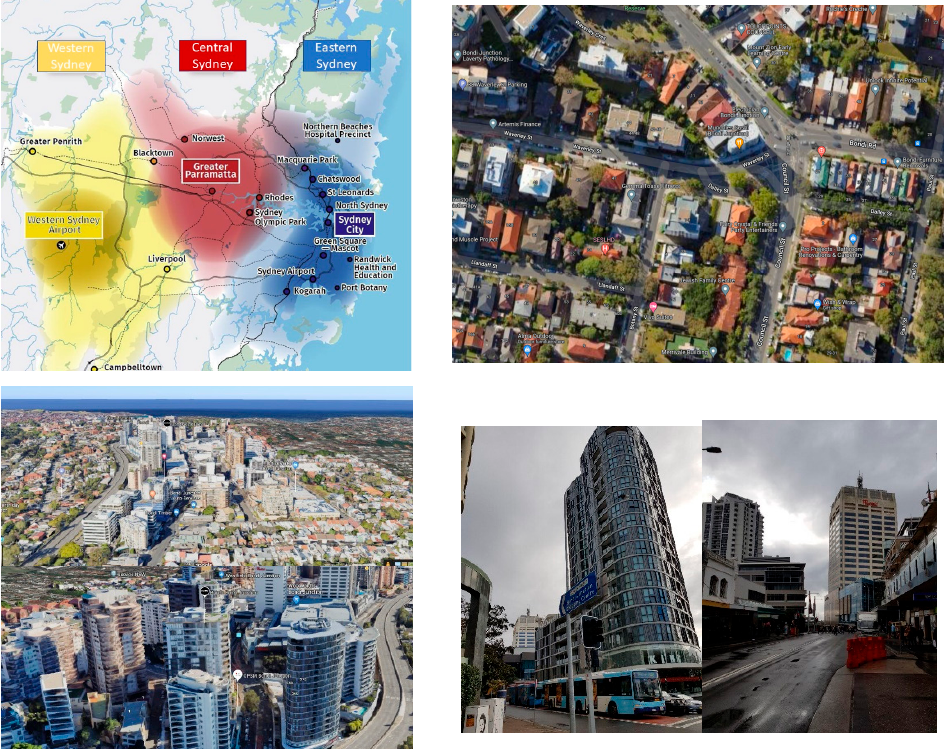
Figure 1. The Greater Sydney area: A metropolis of three cities ( top left figure), the Council St selected for the terrestrial campaign ( right figure), 3D aerial view from Syd Einfeld Dr highway ( bottom left ), pictorial survey at the intersection of oxford street and Bondi Rd ( bottom right ).